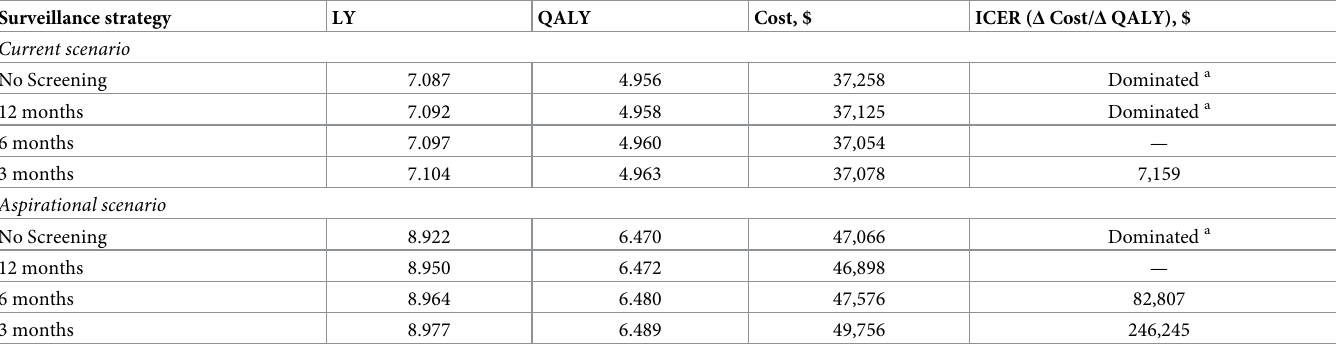
Table 3. Most efficient strategies for current and aspirational